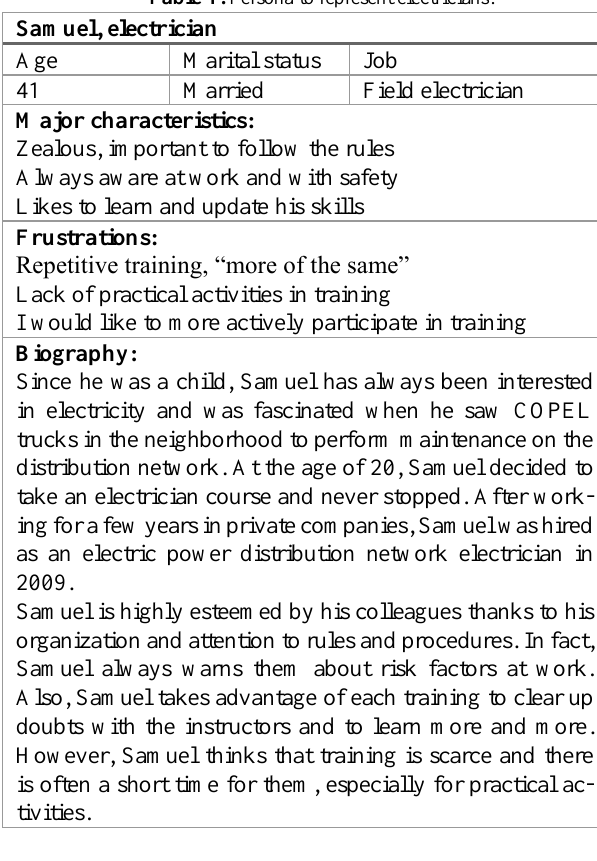
Table 2. Persona to represent